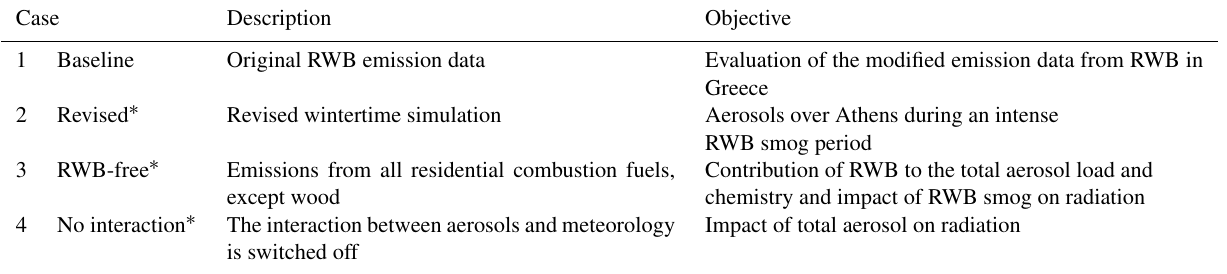
Table 2. Description of modeling runs performed by the current COSMO-ART application from 17 December 2013 to 22 January